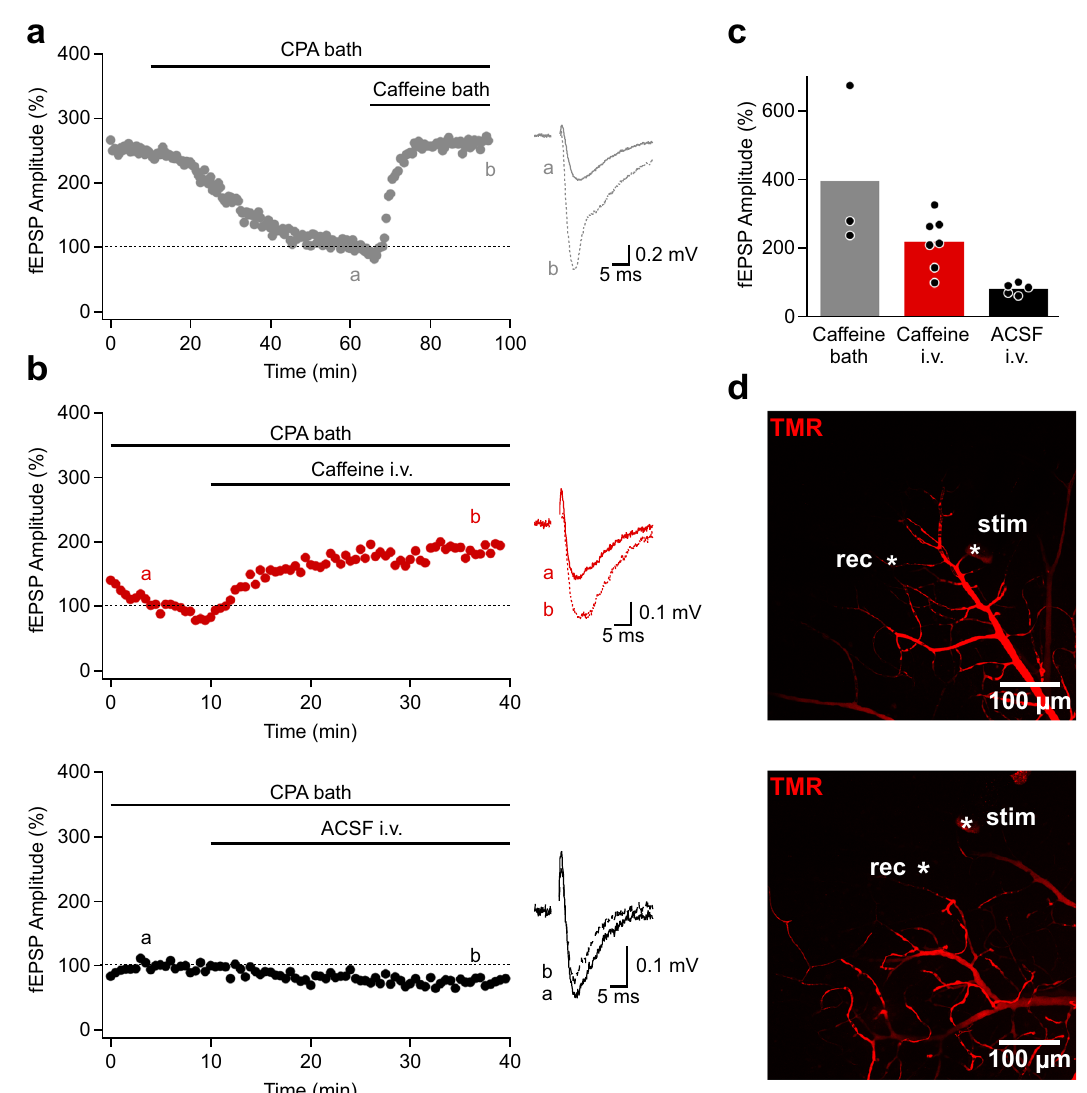
Fig. 8 | Monitoring the pharmacological effect on neuronal responses after drugpassagethroughtheBBB.a TimecourseofanexampleexperimentoffEPSP recordings in the hippocampal area CA1. The adenosine A1-receptor CPA reduces synaptic responses. This effect is antagonized by co-application of caffeine. Inset shows recordings (average of 5 traces) from times indicated by lower case letters. b Toppanel:Intravascular(i.v.)applicationofcaffeinealsoantagonizestheeffectof CPA(pre-applied)andincreasessynapticresponses.Notethedifferenttimescaleof the x-axis when compared to a ). Bottom panel: Control intravascular injection of